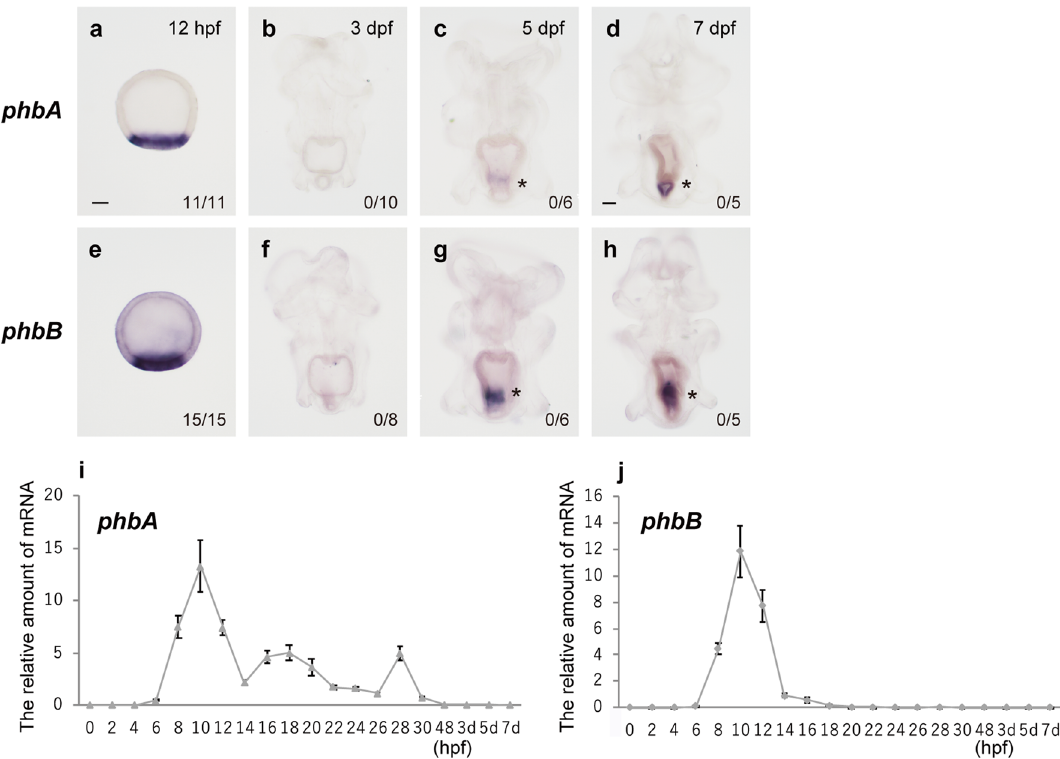
Figure 6. Expression of phbA and phbB in the starfish. The expression of phbA and phbB was examined by WMISH ( a – h ) and quantitative PCR (qPCR; i and j ). ( a – h ) The number in the lower right corner shows the number of embryos or larvae showing a positive WMISH signal/the total number examined. Asterisks indicate nonspecific signals for phb genes (see “Methods”). ( i , j ) The X-axis shows the time after fertilization, and the Y-axis shows the mRNA amounts of phbA ( i ) and phbB ( j ) relative to that of EF1α. Data are shown as the mean ± standard deviation. Scale bars: 50